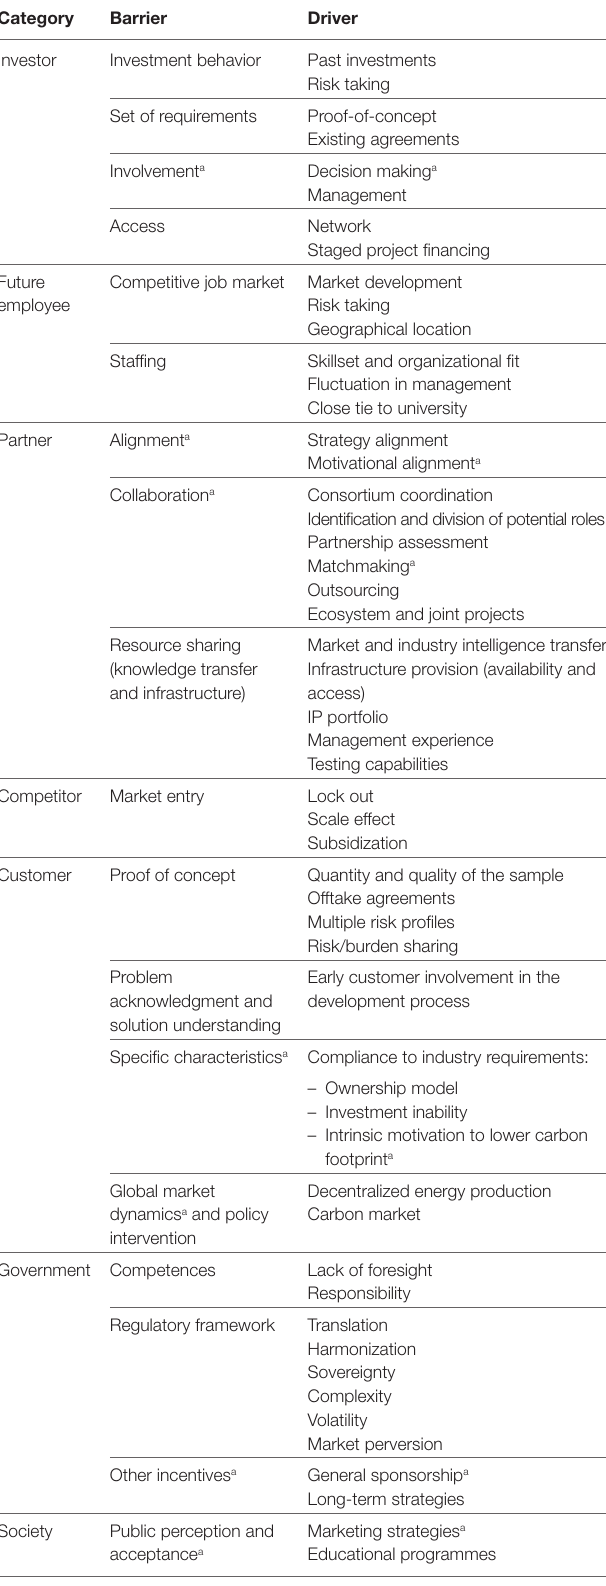
TaBle 2 | Overview of external stakeholder barriers and